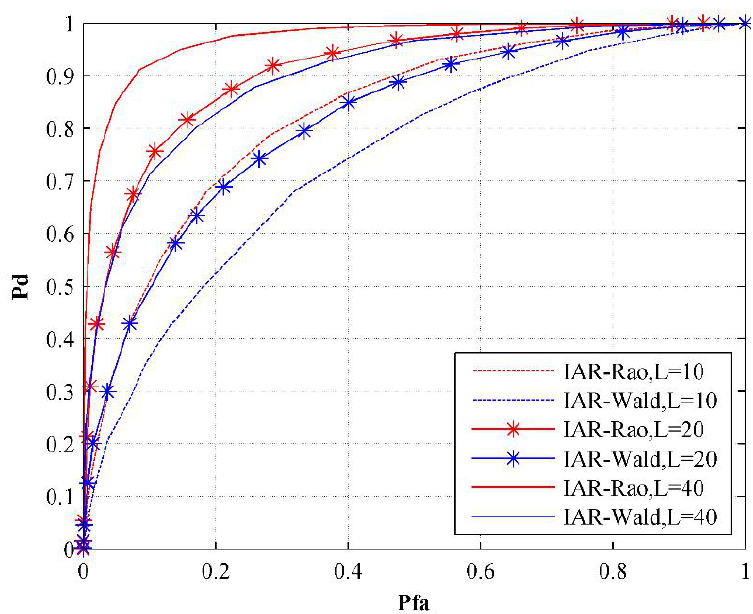
Figure 8. ROC of the AR-Wald detector for N = 16, K = 0, SINR = − 3 dB and various L